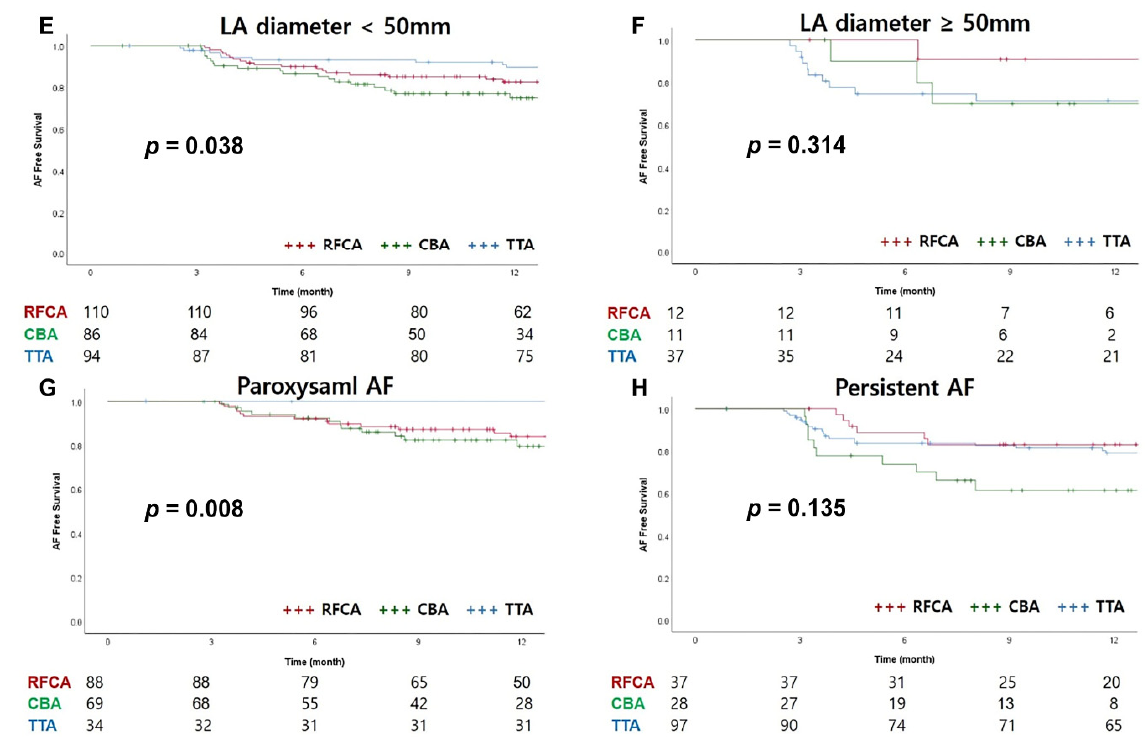
Figure 4. Subgroup analysis of AF-free survival curves. ( A ) Age < 60 years, ( B ) Age ≥ 60 years, ( C ) BMI < 25 kg/m 2 , ( D ) BMI ≥ 25 kg/m 2 , ( E ) LA diameter < 50 mm, ( F ) LA diameter ≥ 50 mm, ( G ) Paroxysmal AF, ( H ) Persistent AF, body mass index; LA, left atrium; AF, atrial fibrillation.